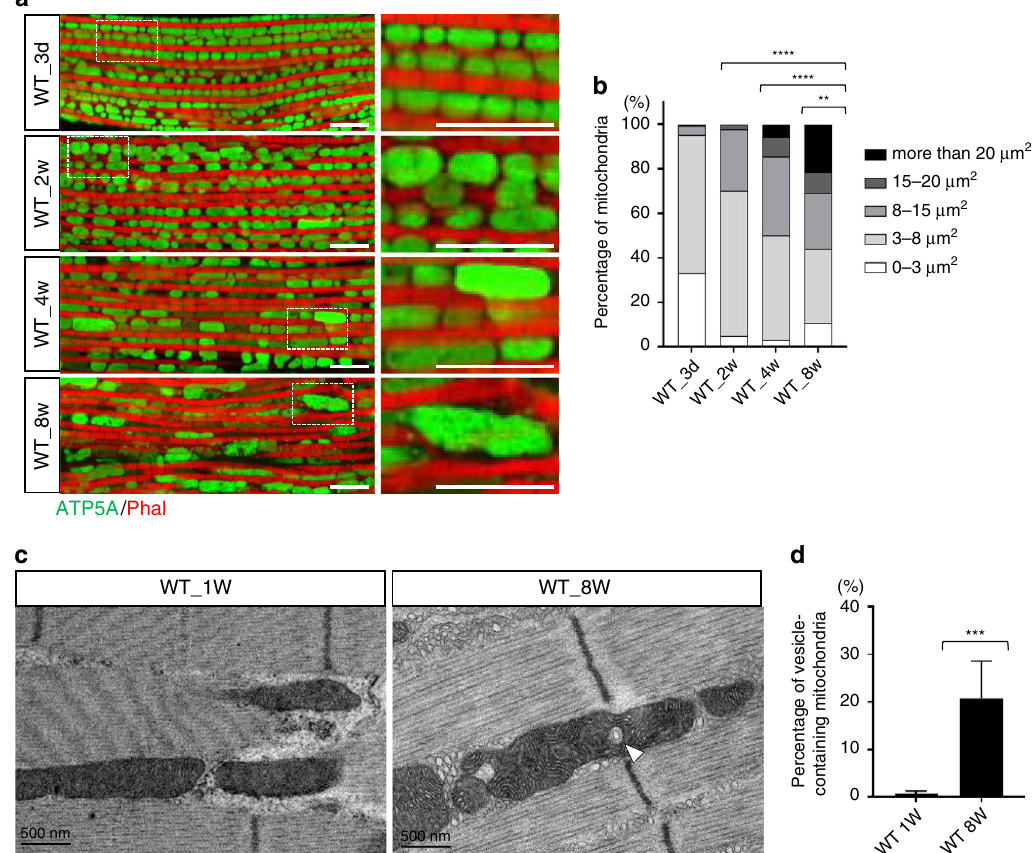
Fig. 1 Mitochondrial size and rate of double-membraned intramitochondrial vesicle formation increases with age. a Immuno fl uorescent staining of mitochondria from D. melanogaster aged 3 days, 2 weeks, 4 weeks, 5 eight weeks. The green channel is ATP5A staining and the red is phalloidin (Phal) staining of F-actin in the muscle. Scale bars: 10 μ m. b Relative abundance of mitochondria of different sizes in the muscle tissue of fl ies of the four age groups. N = 208, 141, 124, and 84 from left to right bars. Statistical test: Chi-Square Test (** p < 0.01; **** p < 0.0001). c TEM images of intramitochondrial vesicles from fl ies aged 1- and 8-week-old (white arrowhead indicates an intramitochondrial vesicle). d The percentage of vesicle-containing mitochondria in fl ies aged 1 and 8 weeks (mean ± SD). N = 718 and 265 from left to right bars. Statistical test: Two-tailed Mann – Whitney U- test (*** p < 0.001). Source data are provided as a Source Data fi